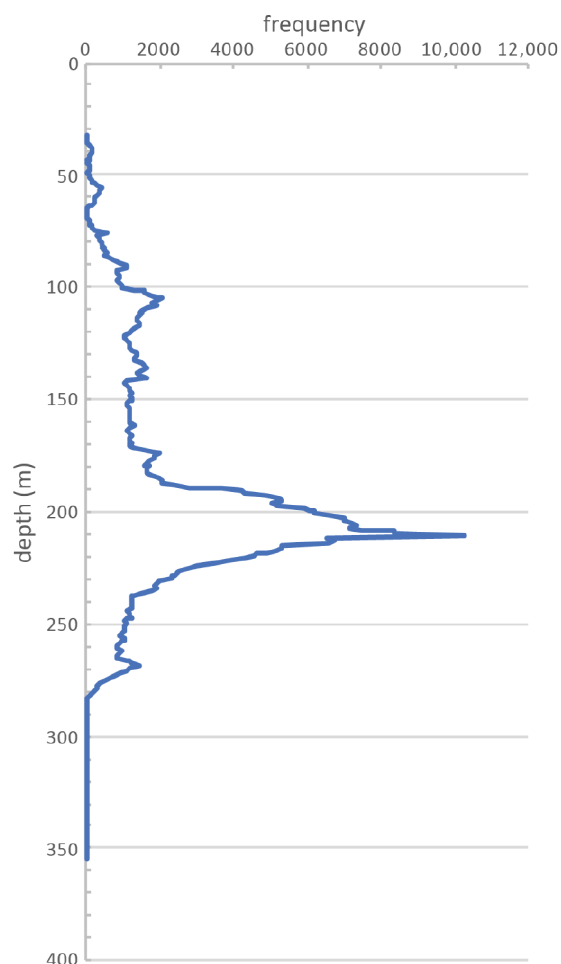
Figure 14. Histogram of ploughmark digital elevation model (DEM) depths in study area. Regions of ploughmarks where mapped in the study area were binned in 1 m depth intervals using the overall 100 m western Gulf of Alaska bathymetry dataset, and then the histogram constructed of those depths.